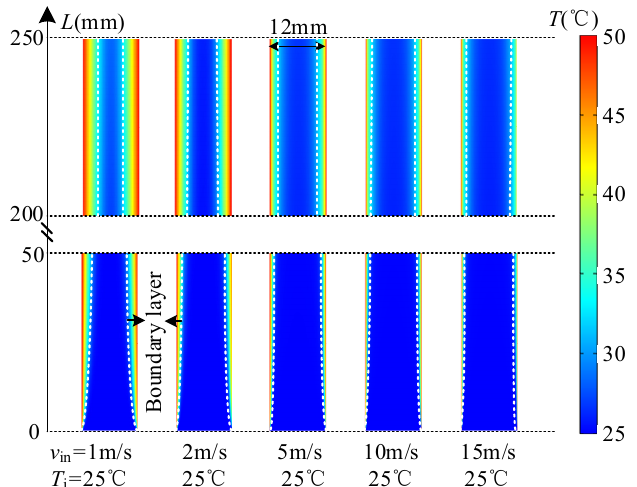
Figure 14. Temperature distribution of the air channel under different wind velocities.